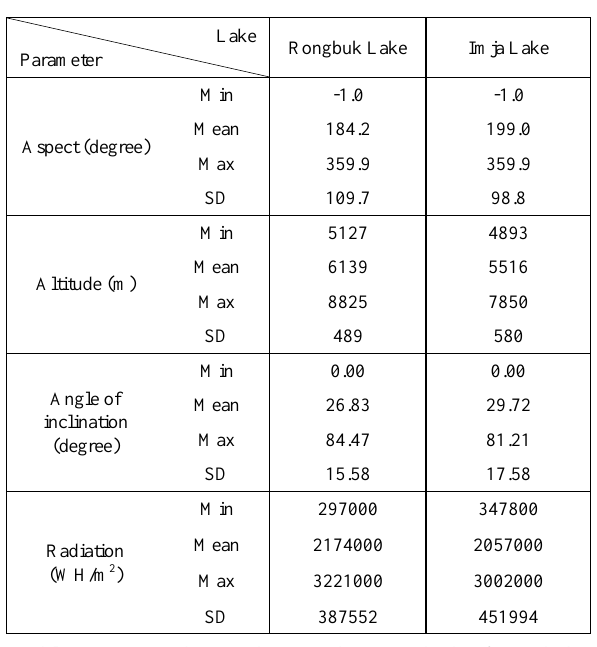
Table 2. Topographic condition in the watersheds of Rongbuk Lake and Imja Lake